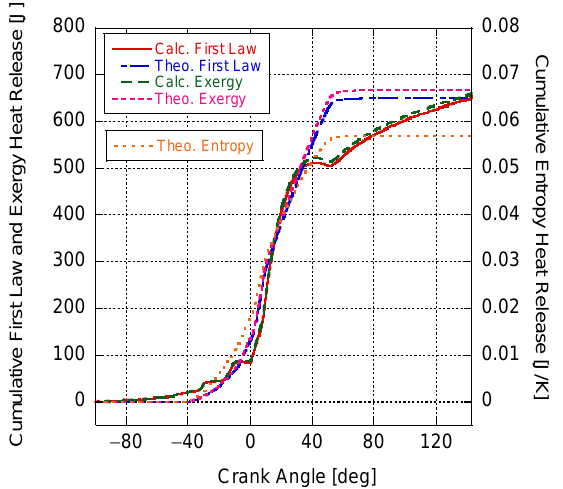
Figure 16. Cumulative theoretical conservation of energy, conservation of entropy, and exergy heat release and the calculated conservation of energy and exergy heat release results.